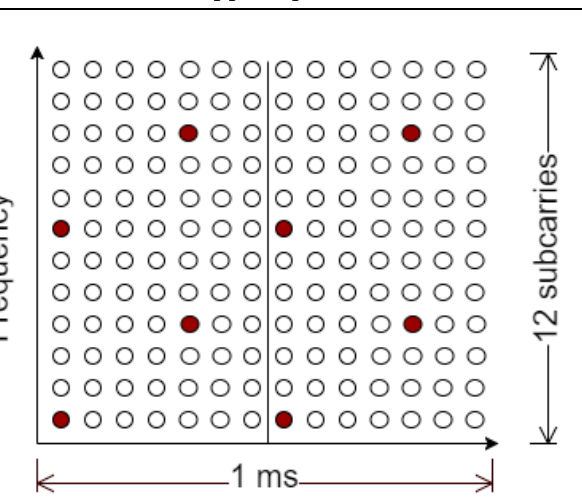
Figure 6. Standard 2D-grid type pilot placement is not well matched to a DBS OFDM